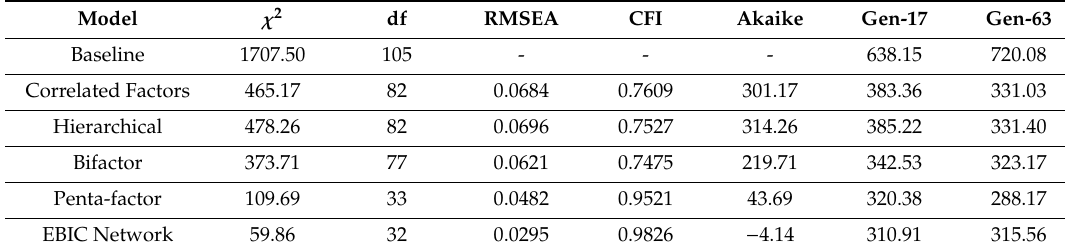
Table 1. Summary of fit indices for models evaluating WAIS-IV partial correlation. RMSEA is the root mean squared error of approximation, CFI is the comparative fit index, Gen-17 is the χ 2 value for generalization of training weights to correlations from individuals between 16 and 19 years of age and Gen-63 is generalization of training weights to correlations from individuals between 55 and 69 years of age.